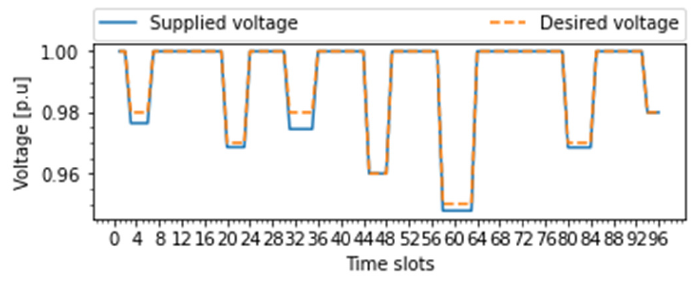
Figure 7. Voltage deviations with stochastic ‐ based MPC approach.